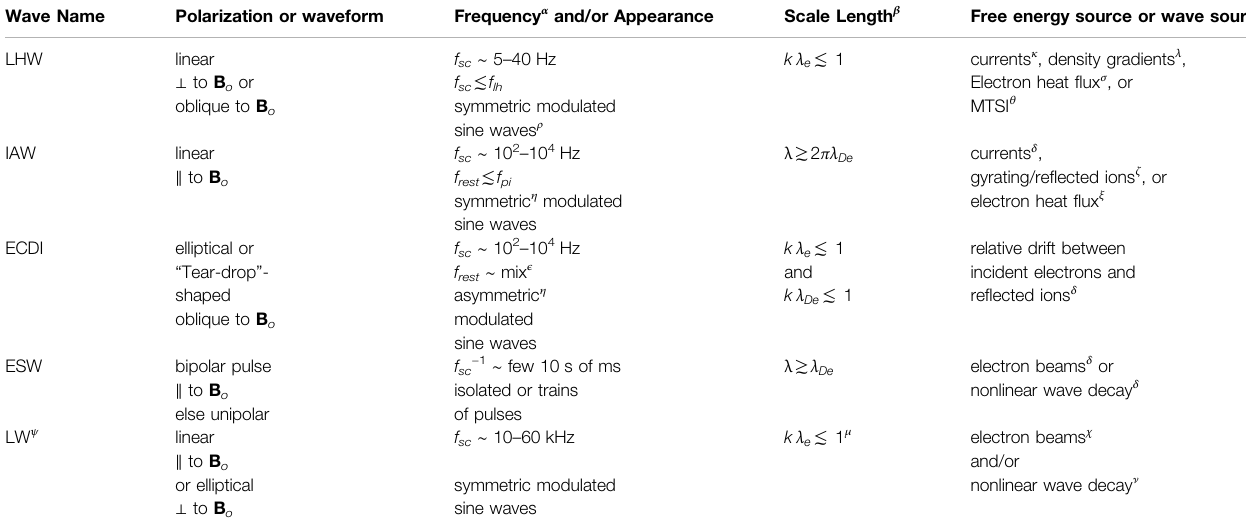
TABLE 1 | Common Electrostatic Waves at/near Collisionless